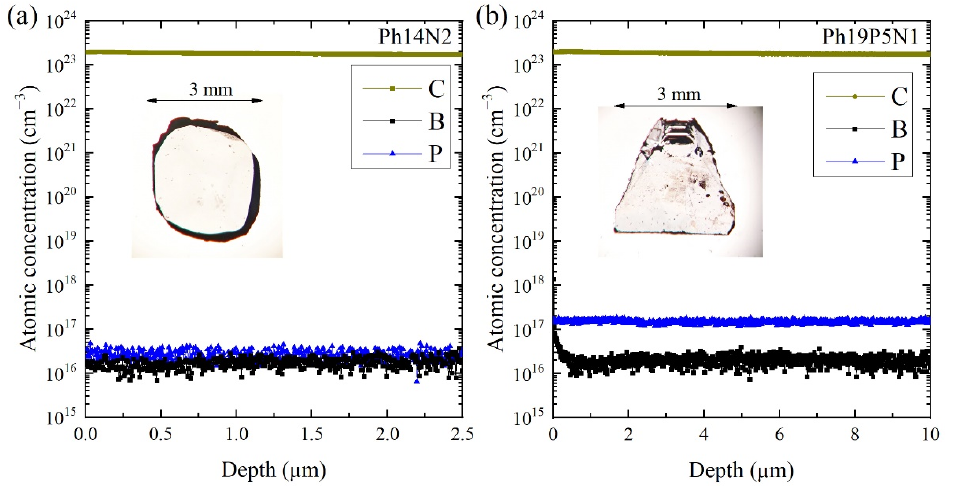
Figure 1. SIMS analysis for the content of boron and phosphorus of samples ( a ) Ph14N2 and ( b ) Ph19P5N1. The insets show photographs of the corresponding